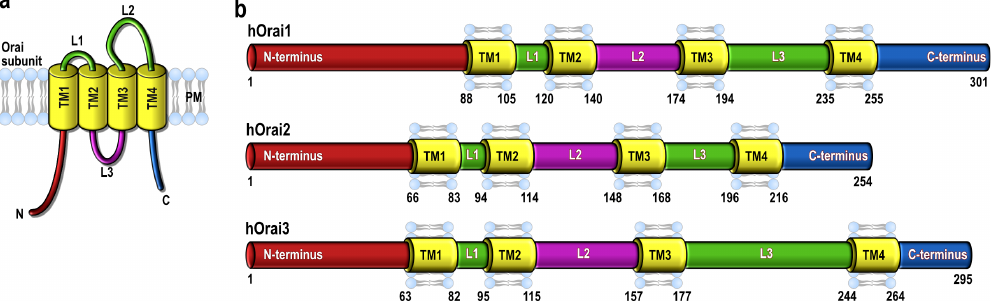
Figure 1. ( a ) Predicted topology of Orai proteins. ( b ) A schematic representation of the three mem- bers of the Orai family with their structural domains. Abbreviations: L, loop; TM, transmembrane